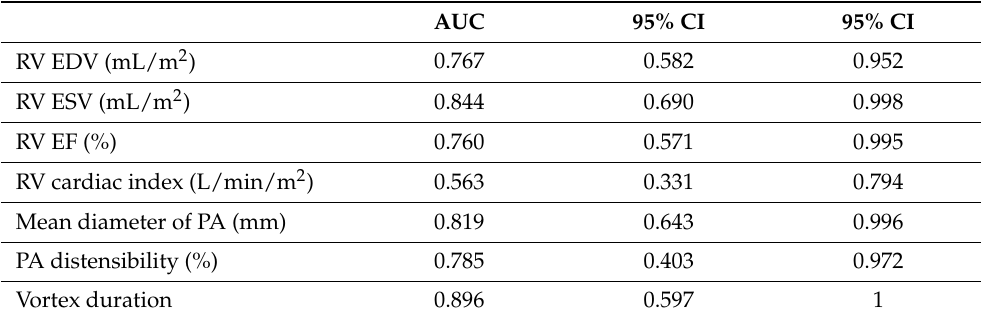
Table 5. Receiver operating characteristic curve analysis of MR parameters to detect pulmonary hypertension (defined a mean PAP ≥ 25 mmHg).